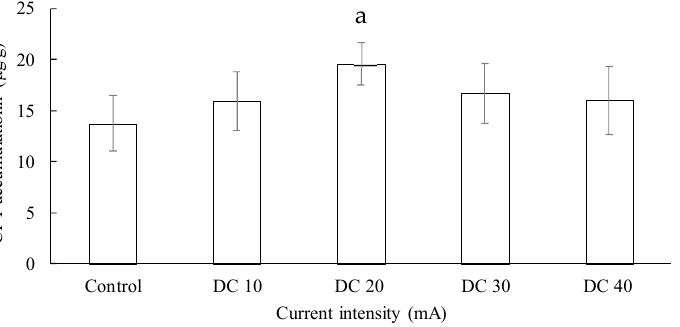
Figure 9. Effects of DC intensities (10, 20, 30 and 40 mA) on CPT accumulation in O. ridleyana leaves. The values are expressed as mean ± SD ( n = 3); a: significant at p < 0.05 vs. control.